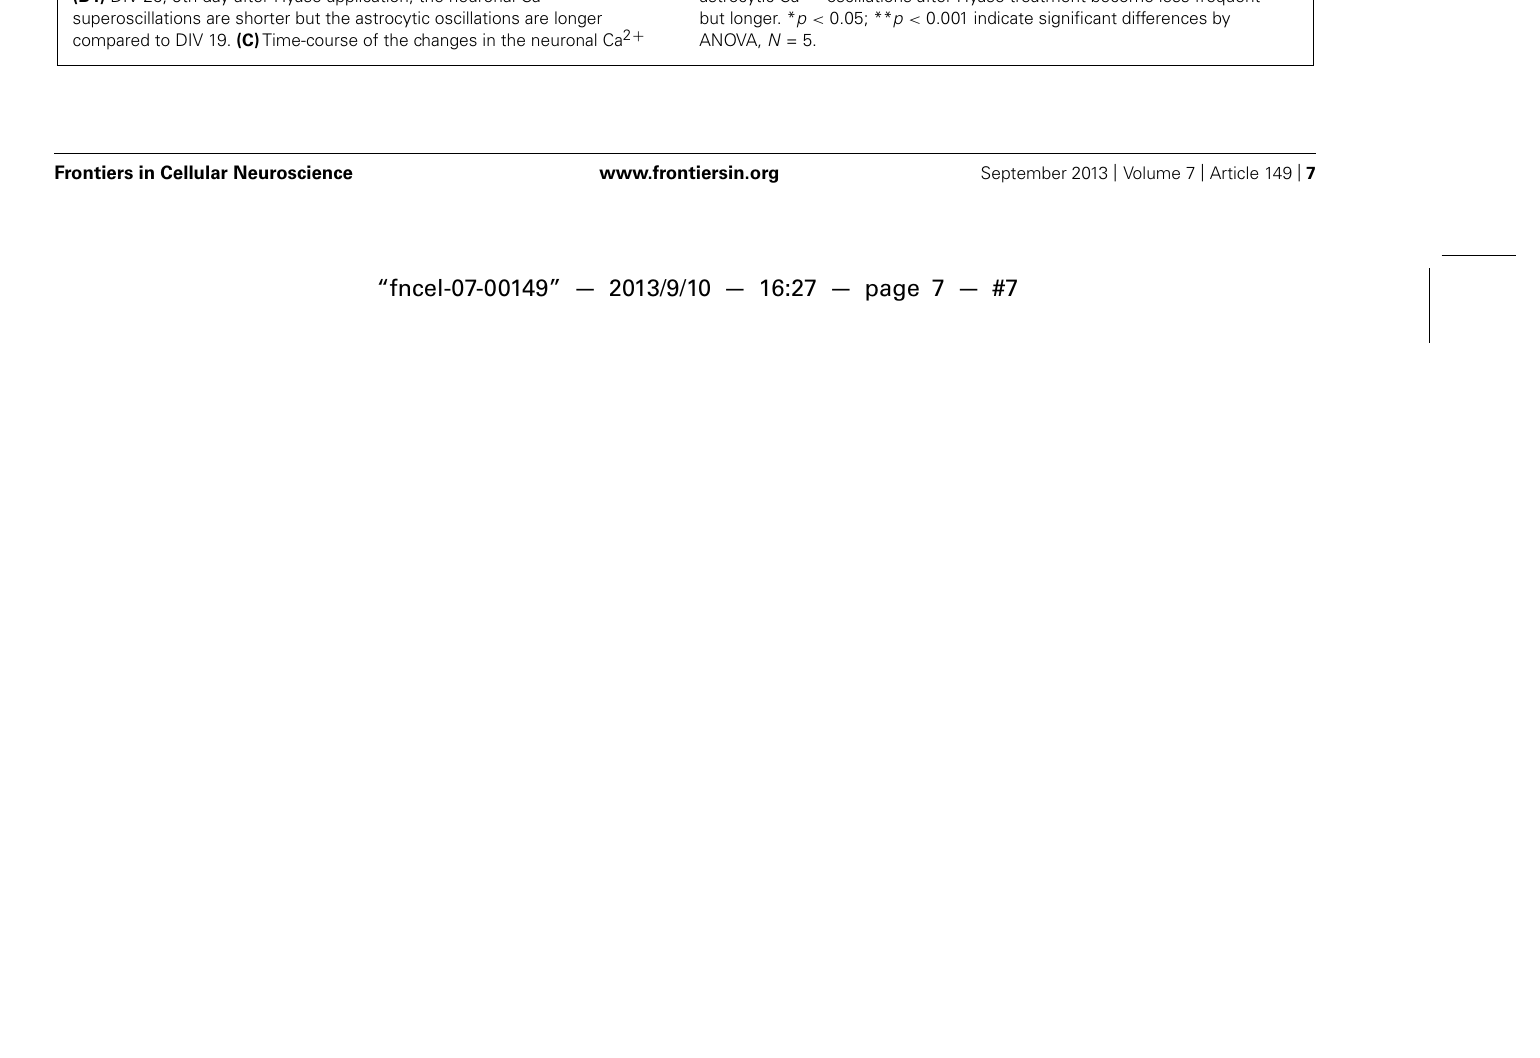
FIGURE 4 | Hyaluronidase-induced Ca 2 + superoscillations in the neuronal (upper curves) and glial (lower curves) networks in dissociated hippocampal cultures. (A,B) Spontaneous Ca 2 + oscillation recordings from: (A1) DIV 17, intact; (A2) DIV 19, control; (A3) DIV 20, control; (A4) DIV 26, control; (B1) DIV 17, intact; (B2) DIV 19, 2nd day after Hyase application, showing the appearance of neuronal Ca 2 + superoscillations with maximal duration; (B3) DIV 20, 3rd day after Hyase application, some astrocytic Ca 2 + transients demonstrate synchronization with the neuronal superoscillations; (B4) DIV 26, 9th day after Hyase application, the neuronal Ca 2 + superoscillations are shorter but the astrocytic oscillations are longer compared to DIV 19. (C) Time-course of the changes in the neuronal Ca 2 +